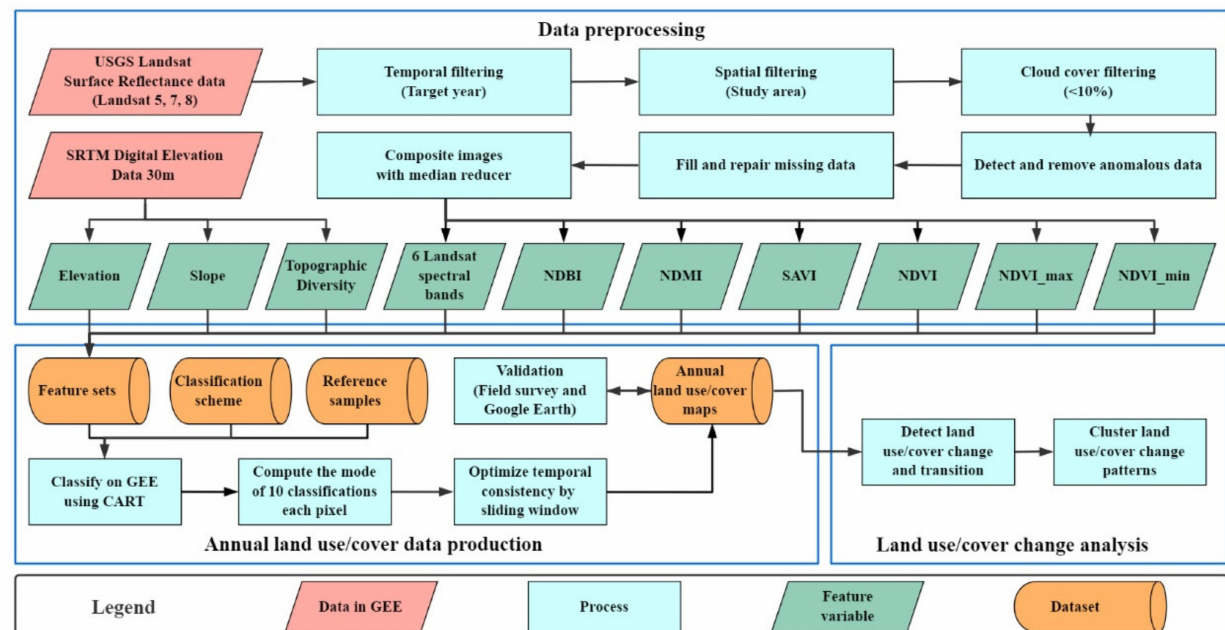
Figure 2. Workflow for the long-term annual land use/cover production and land use/cover change analysis in this study. Major modules include data preprocessing, annual land use/cover data production, and land use/cover change analysis.